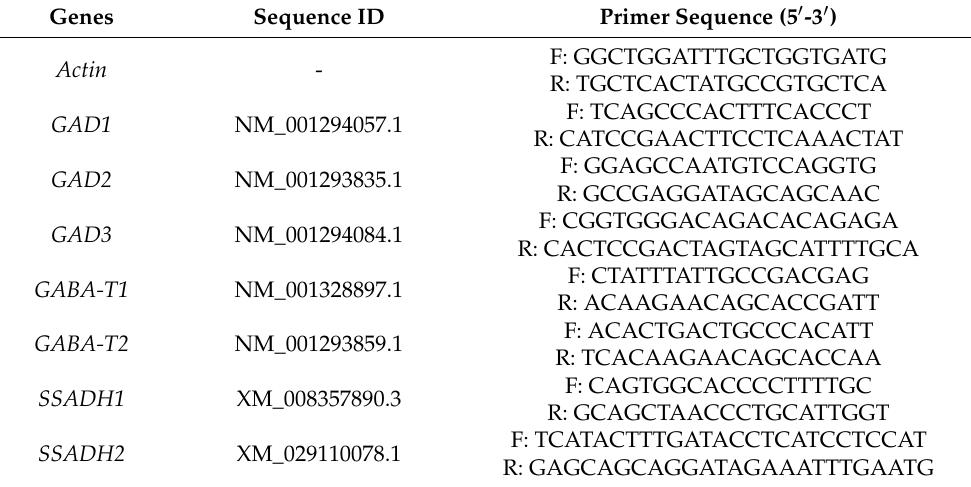
Table 1. Primer sequences of the GABA shunt genes used for quantitative real time PCR reactions. Genes Sequence